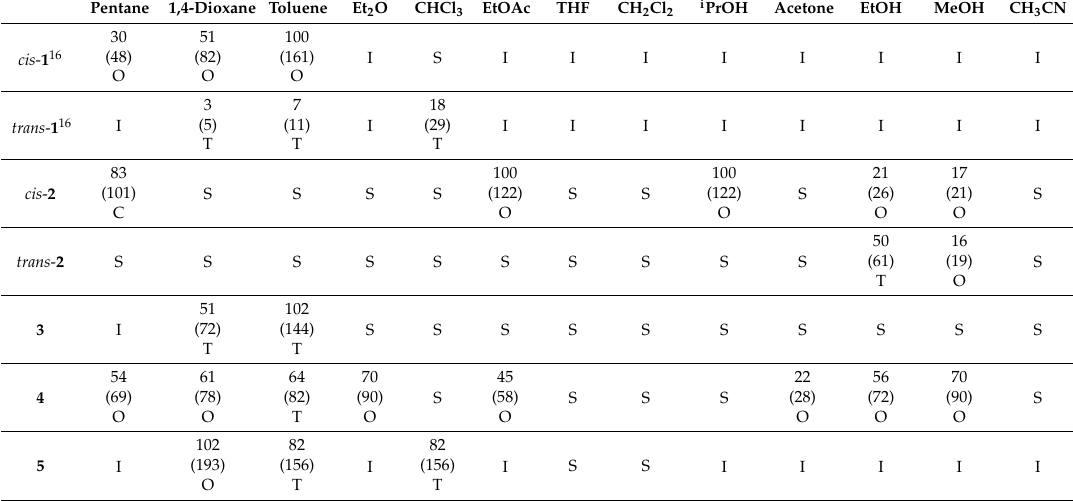
Table 1. Gelling behavior of previously known LMWOG 1 16 and of the new compounds 2 – 5 in common organic solvents a, b, c